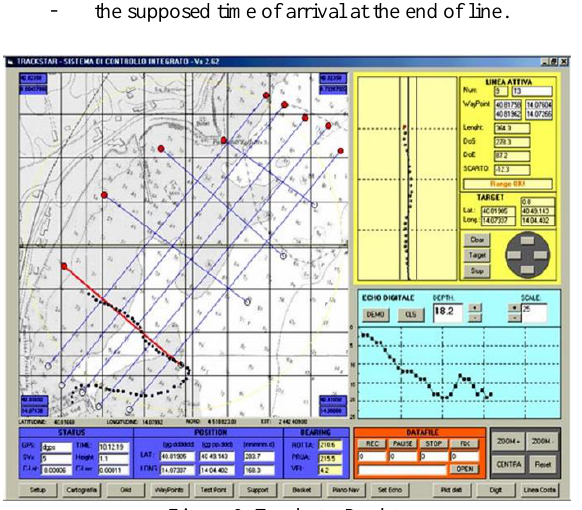
Figure 9. Trackstar Desktop